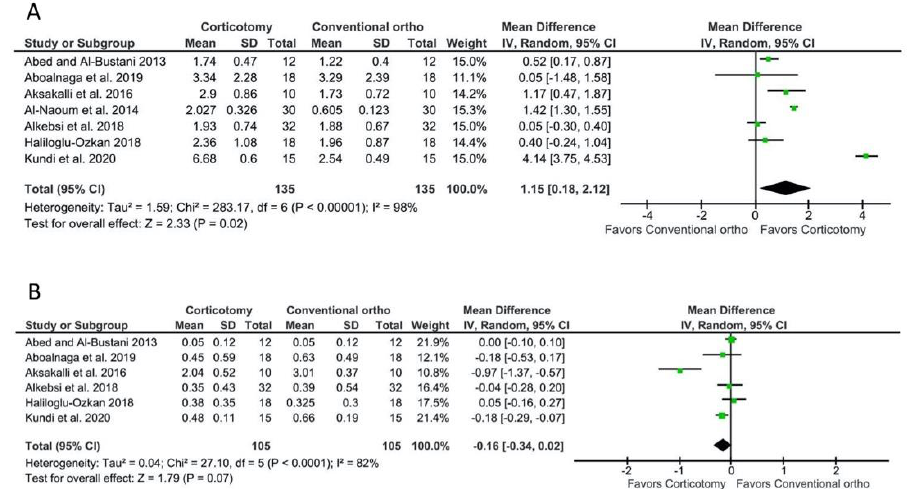
Figure 2. Meta-analyses for the outcomes of a localized corticotomy (distal to the canine) compared to a conventional orthodontic treatment. ( A ) For canine distalization, the WMD was 1.15 mm (95% CI = 0.18–2.12 mm, p = 0.02), favoring the corticotomy group. ( B ) For molar anchorage loss, the WMD was − 0.16 mm (95% CI = − 0.34–0.02 mm, p = 0.07), representing no statistically significant difference between the groups.